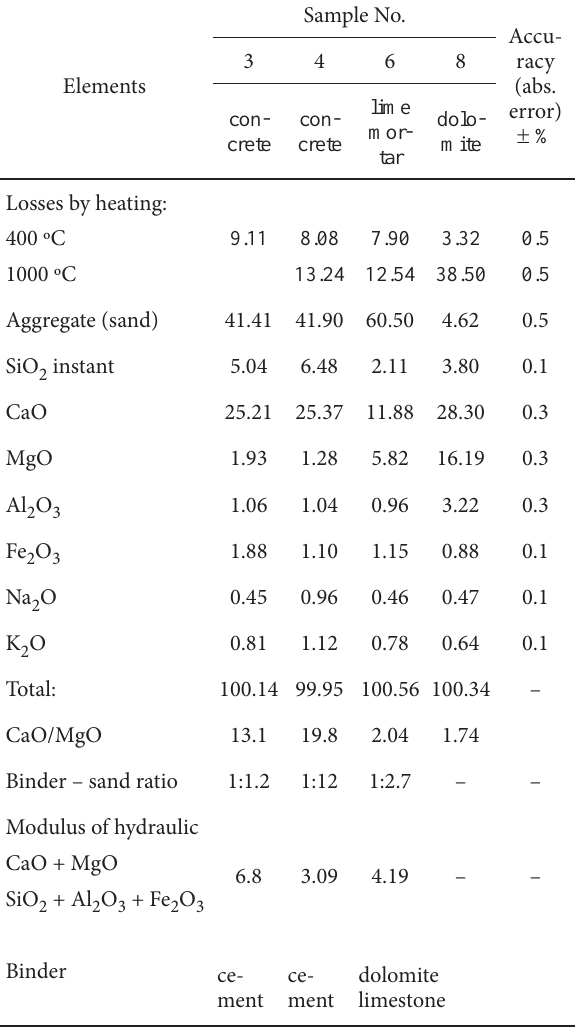
Table 3. Recalculated aggregate composition in % of mass Particle size,